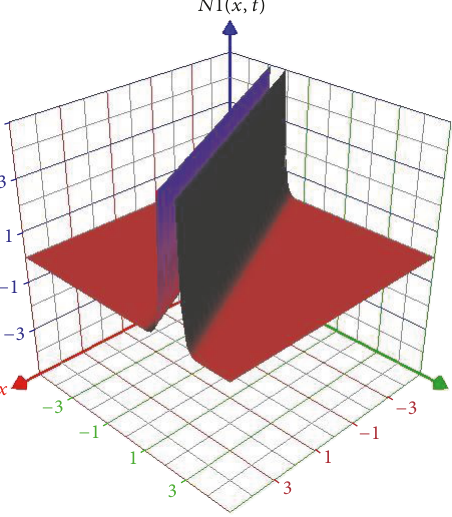
Figure 3: The solitary wave of the real part of 𝐸 2 (𝑥,𝑡) in (32) for −5 ≤ 𝑥 ≤ 5 , 0 ≤ 𝑡 ≤ 1